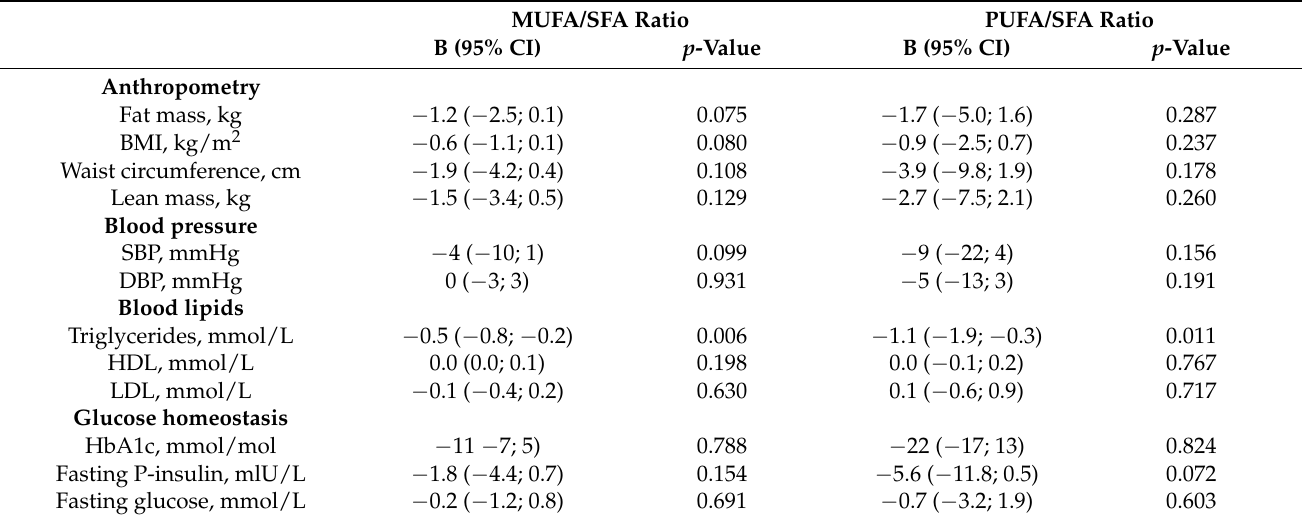
Figure 2. Daily calorie intake at baseline and 12 weeks. One line per participant starting with kcal intake per day at baseline and ending with kcal intake per day at 12 weeks. Grey lines represent participants of the Paleolithic diet only group and black lines participants of the Paleolithic diet and exercise group. A higher Paleo ratio at 12 weeks was associated with lower fat mass, BMI, waist cir- cumference, SBP, and triglyceride levels after 12 weeks of intervention in regression model 2 (all p < 0.05, Table 3). The Paleo ratio after 12 weeks explained 89% of the lower fat mass and BMI after the intervention according to the regression model (adjusted R 2 = 0.89 for model 1 and model 2). Table 3. Association between the MUFA/SFA ratio and PUFA/SFA ratio and outcome variables after 12 weeks of